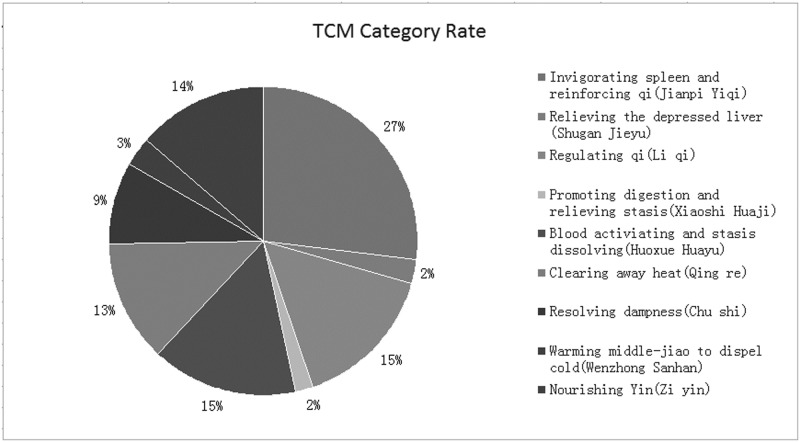
TCM category rate.